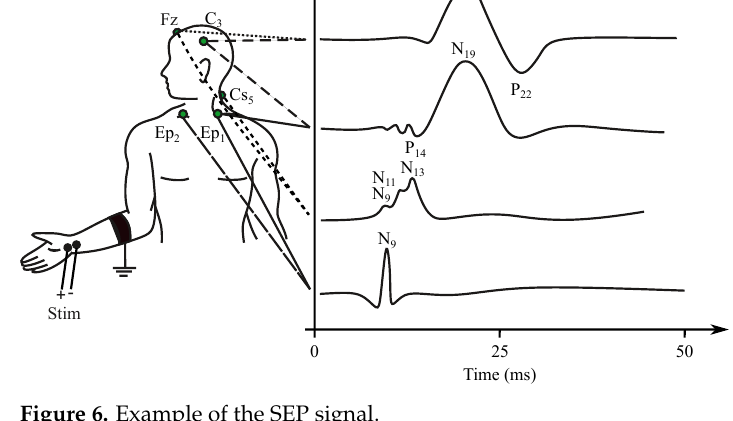
Figure 6. Example of the SEP signal.